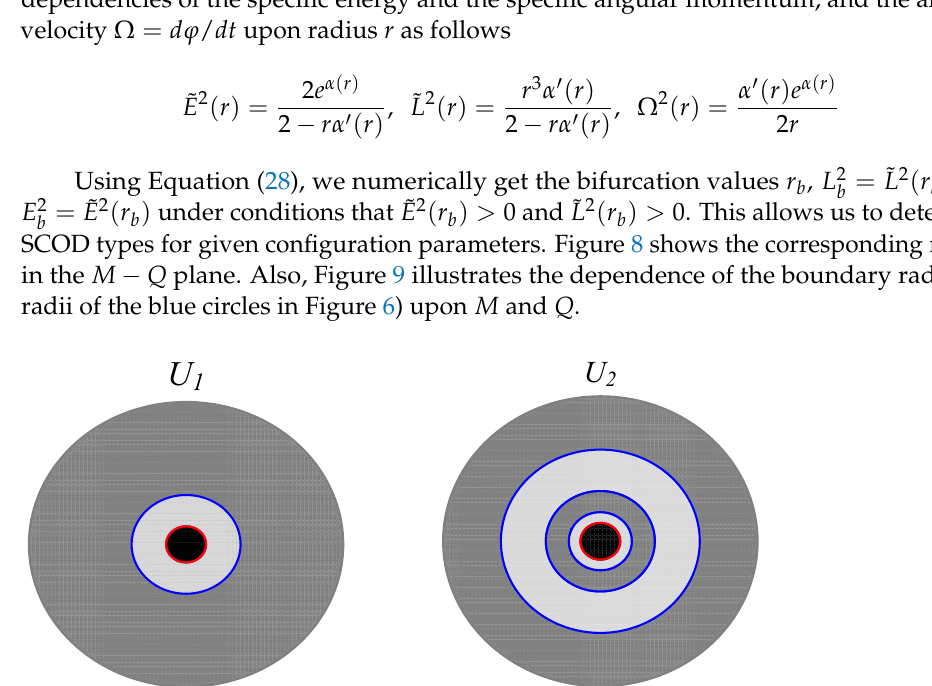
Figure 6. The schematic examples of possible SCODs in the equatorial plane. In both cases, black spots in the center represent SS at finite values of r . Dark and light gray rings correspond to the sequences of SCO and unstable circular orbits correspondingly. Blue circles show the boundary radii of SCOD as described in Table 1.